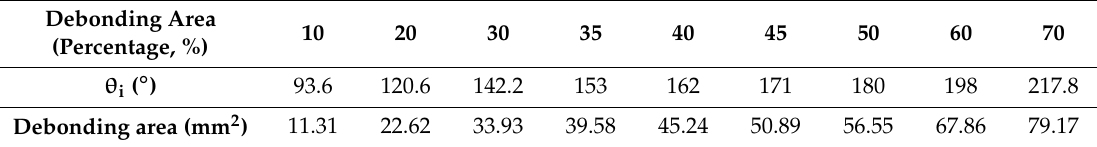
Figure 10. PTFE film controls the debonding area of the piezoelectric sensor. The corresponding debonding areas are : ( a ) 10%; ( b ) 20%; ( c ) 30%; ( d ) 35%; ( e ) 40%; ( f ) 45%; ( g ) 50%; ( h ) 60% and ( i ) 70%. Table 1. The corresponding values of debonding areas and θ i (I = 1, 2, ... , 9) when the debonding areas of actuator set from 10% to